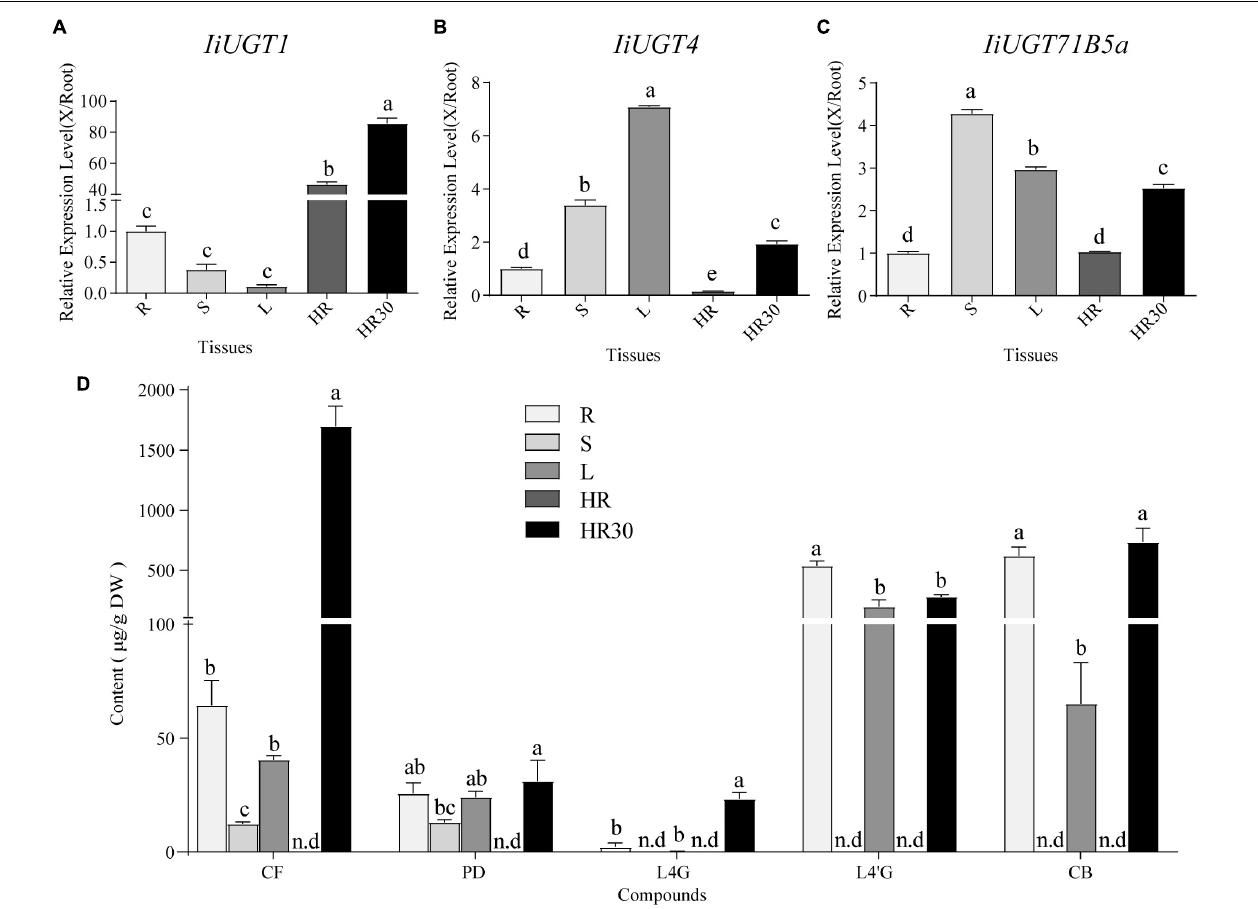
FIGURE 5 | qRT-PCR analysis of IiUGT1 , IiUGT4 , IiUGT71B5a expression patterns in I. indigotica and the accumulation of lignan glycosides in I. indigotica. Relative expression levels of IiUGT1 (A) , IiUGT4 (B) and IiUGT71B5a (C) in I. indigotica were performed as described in the experimental procedures using total RNAs extracted from different organs. The tissue samples are listed as follows: R, roots; S, stems; L, leaves; HR, hairy roots cultivated in MS liquid medium for 2 weeks; HR30, hairy roots cultivated in 6,7-V liquid medium for 30 days. The expression of IiUGT in root tissue was defined as 1.0. (D) Quantities of lignan glycosides from different tissues of I. indigotica . The tissue samples are listed as follows as above. CF, coniferin; PD, pinoresinol diglucoside; L4G, lariciresinol-4- O - β -D-glucoside; L4 (cid:48) G, lariciresinol-4 (cid:48) - O - β -D-glucoside; CB, clemastanin B; n.d, not detected. All data represent the mean ± standard deviation (SD) of three biological replicates. Different letters above the error bars indicate significant differences ( p < 0.05) according Tukey’s